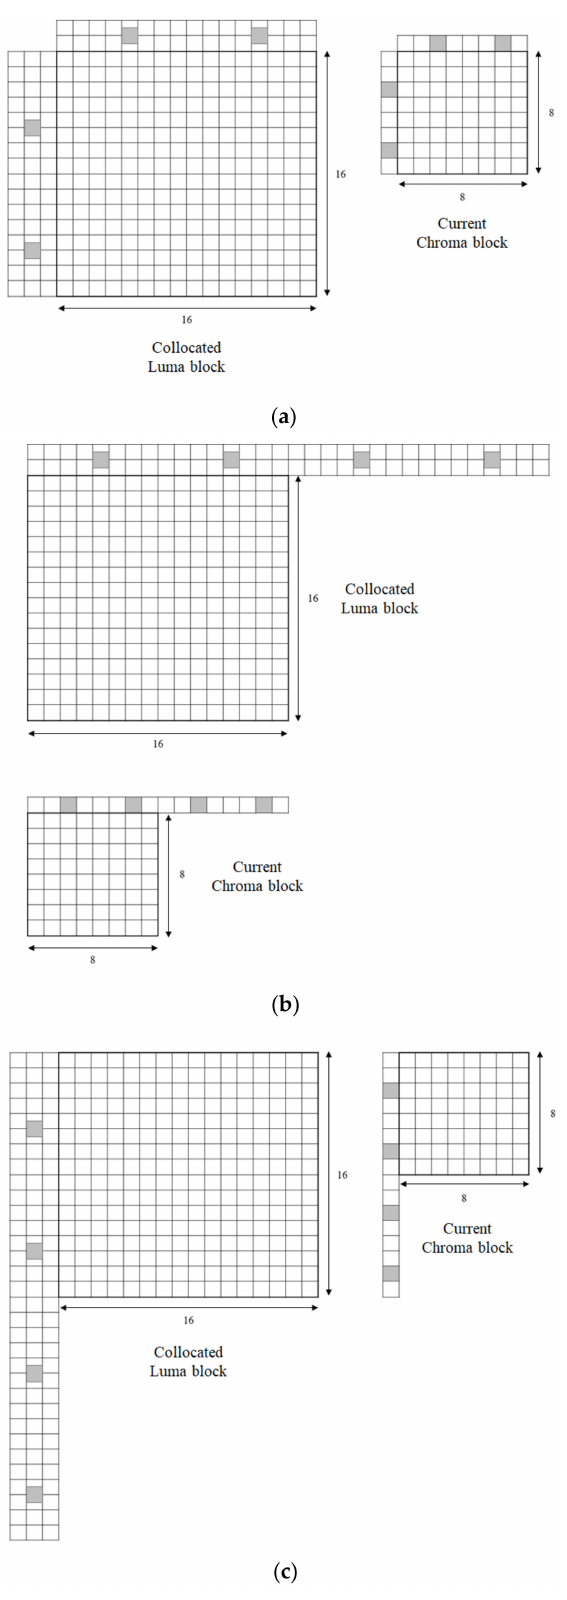
Figure 2. Subsampled sample positions for the neighboring chroma samples and their corresponding neighboring luma samples for a given 8 × 8 chroma block: ( a ) LT_CCLM mode; ( b ) T_CCLM mode; ( c ) L_CCLM